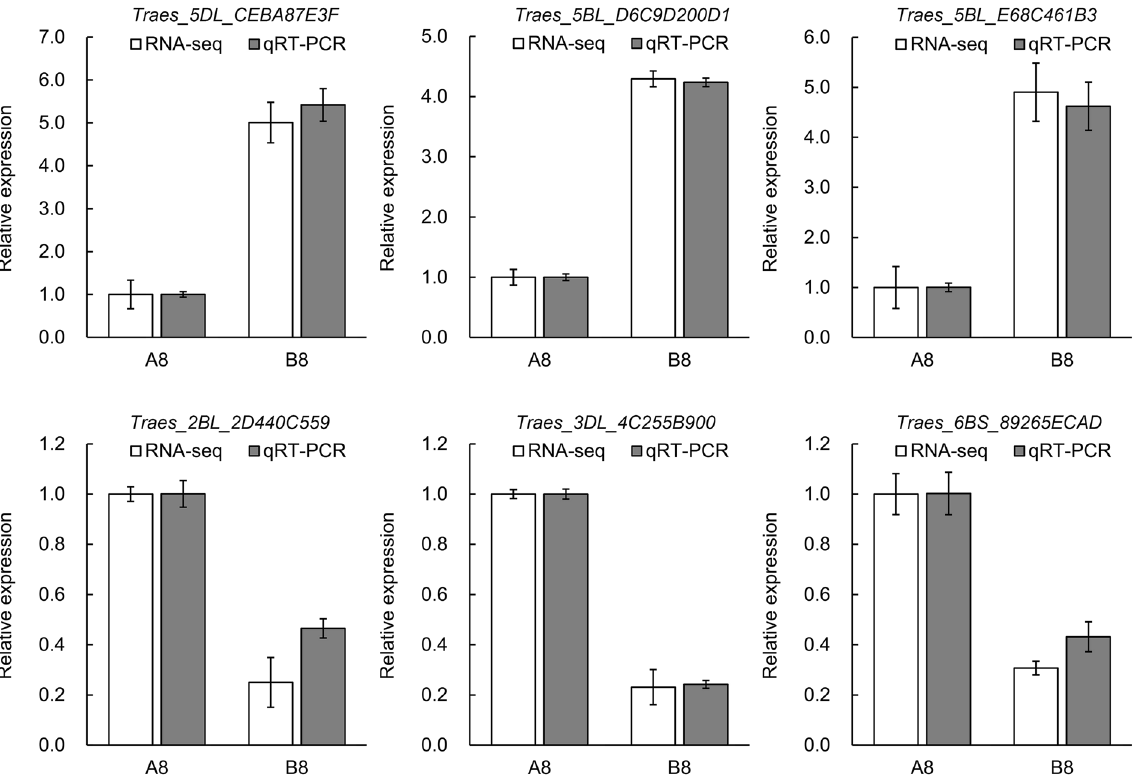
Figure 3. Validation of differentially expressed genes by qRT-PCR. A8: N0 seeds at 8 HAI. B8: N240 seeds at 8 HAI. The relative expression level of each gene was expressed as the fold change between N0 and N240 in the RNA-Seq data (white bar) and qRT-PCR data (gray bar). The wheat Actin gene was used as an internal control to normalize the expression data. Error bars represent the standard deviation for three